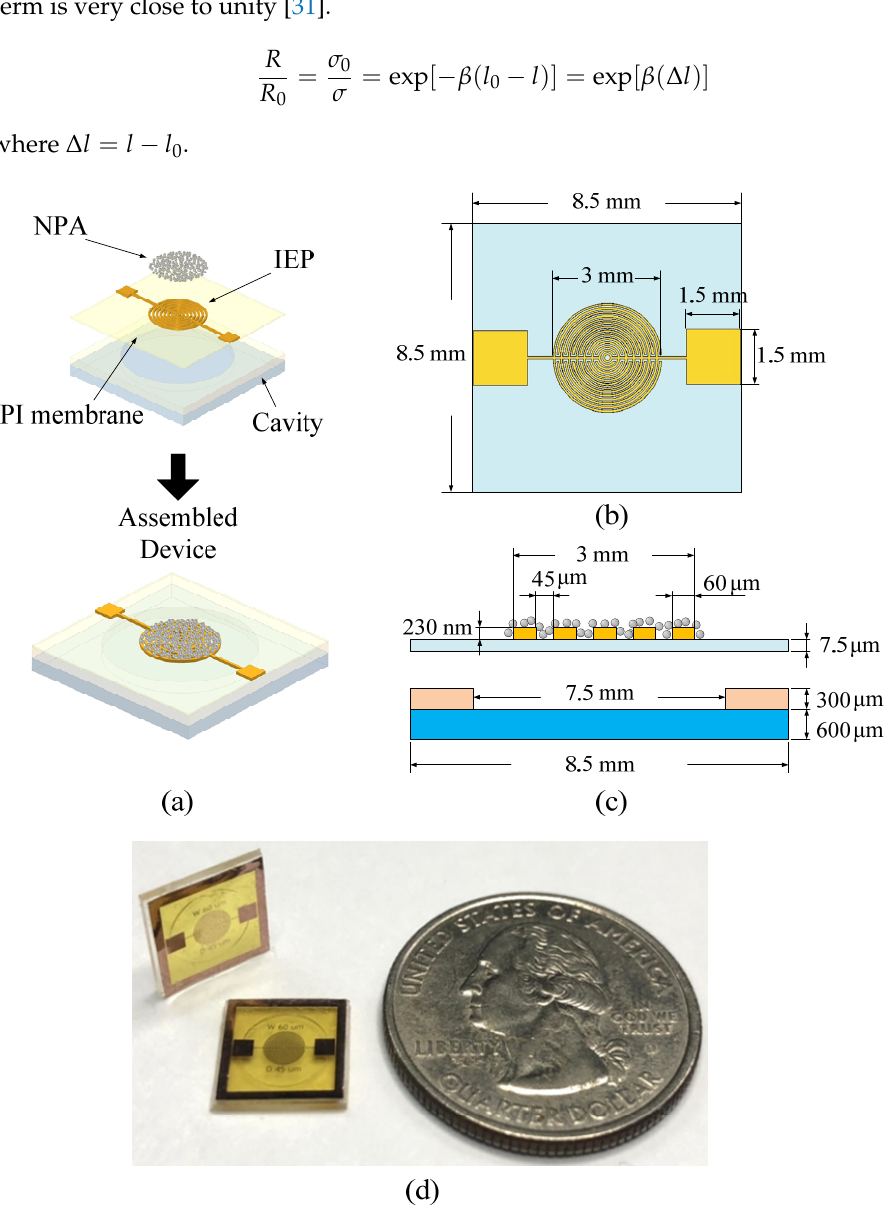
Figure 1. ( a ) Schematic of the proposed pressure sensor. ( b ) The top view and ( c ) the cross-sectional view of the device. ( d ) The picture of the fabricated devices.